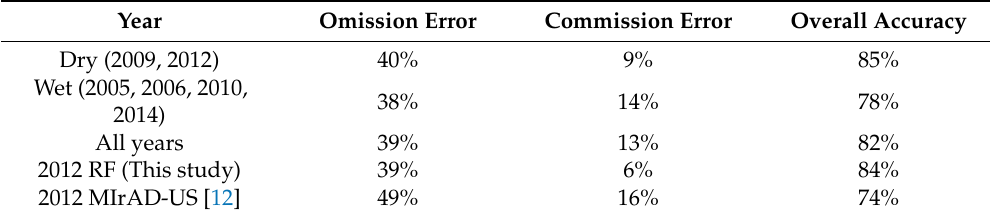
Table 3. Irrigation mapping accuracy evaluated using manually labeled data points. Omission error describes the percentage of irrigated training points that are classified as rainfed (false negative), while commission error describes the percentage of rainfed training points that were classified as irrigated (false positive). The accuracies of RF classifier and MIrAD-US [12] are compared for 2012 when both the manually labeled data points and MIrAD-US map are available.